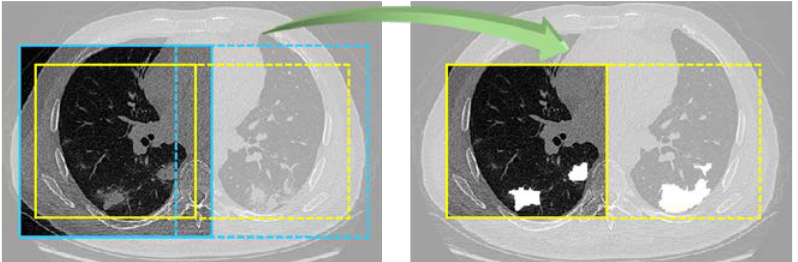
Figure 5. Overlap-tile strategy. Blue line area is output area. Through the instructions of the green 3D arrow, the actual reserved output is yellow line area.